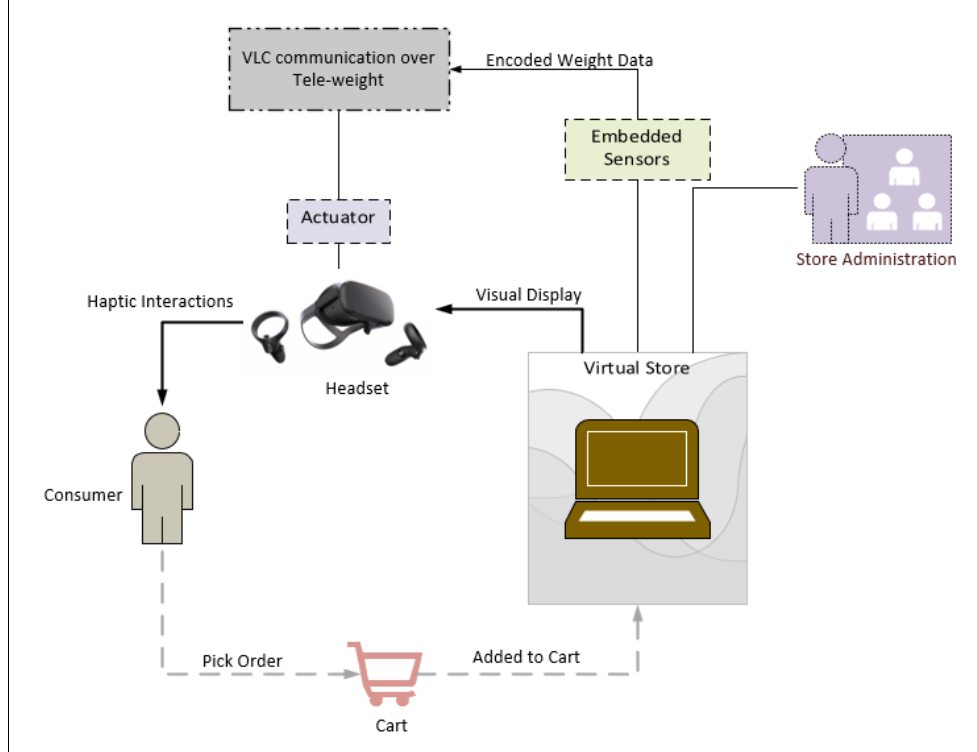
Figure 2. VLC Tele-weight Conceptual